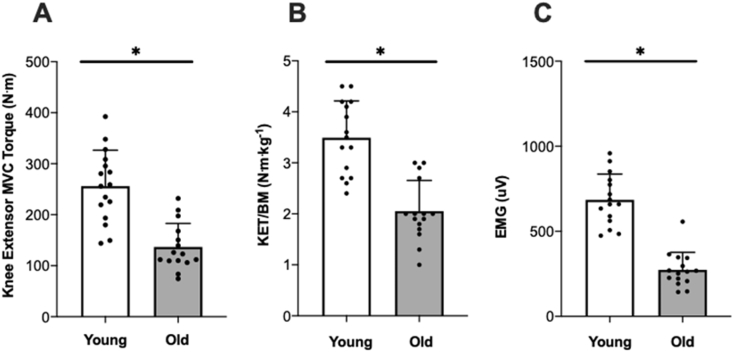
Maximal knee extensor torque and peak EMG activity.Group mean ± standard deviation for (A) Maximal quadriceps knee extension torque (N.m), (B) maximal quadriceps knee extension torque relative to bodyweight (N.m.kg−1); and (C) peak electromyography (EMG) activity (uV) achieved during a 90o isometric knee extensor contraction for young (white bars) and old (grey bars) adults. * Indicate significant (P < 0.05) differences between groups. MVC, Maximal voluntary contraction; KET, Knee-extension torque; BM, Body mass.